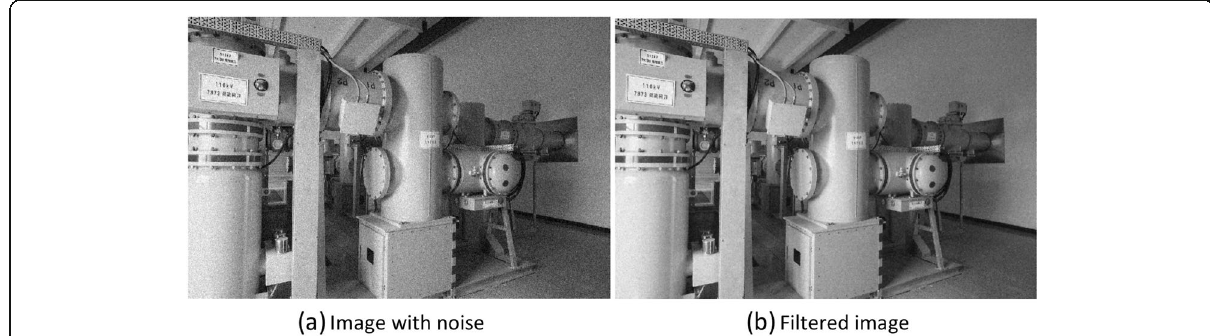
Fig. 2 Image filtering processing. a Image with noise. b Filtered